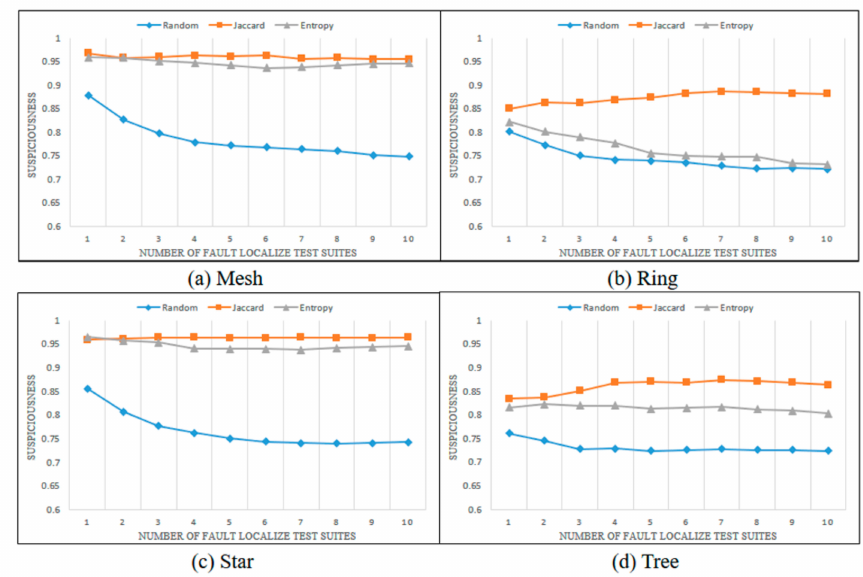
Figure 10. Average suspiciousness of faulty statements (non-mutant